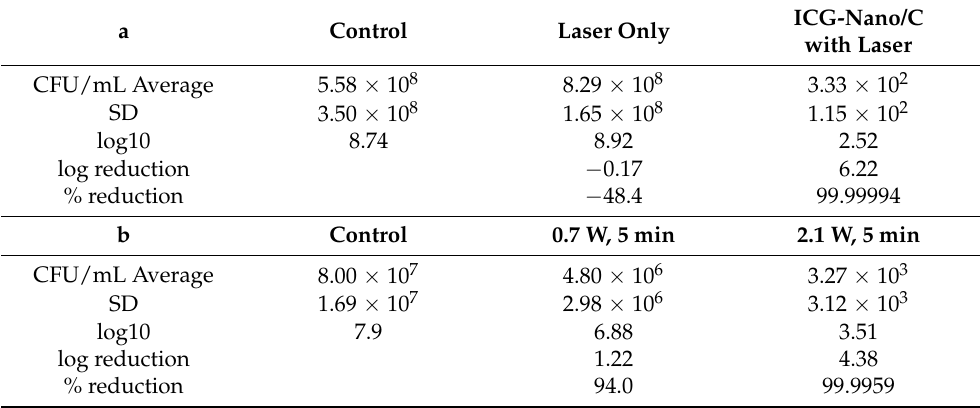
Table A2. Confirmation that the bactericidal effect is due to aPDT/PACT. Actual values of data indi- cated in Figure 2 are shown. ( a ) Comparison of bactericidal effects with and without photosensitizers. The laser was applied at 2.1 W for 5 min without air-cooling. ( b ) Bactericidal effect with air-cooling (2 L/min). The laser was applied for 5 min.